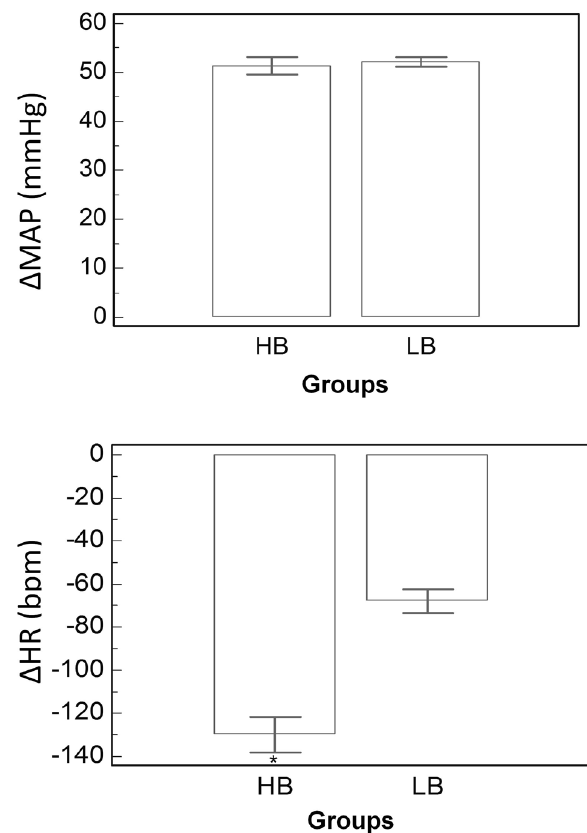
Figure 1 - Increase in mean arterial pressure (MAP, mmHg) and decrease in heart rate (HR, bpm) in response to phenylephrine (PE, 8 m g/kg i.v.) in HB (n=14) and LB (n=8) groups. * p<0.001: difference in LB. Means+SEM.